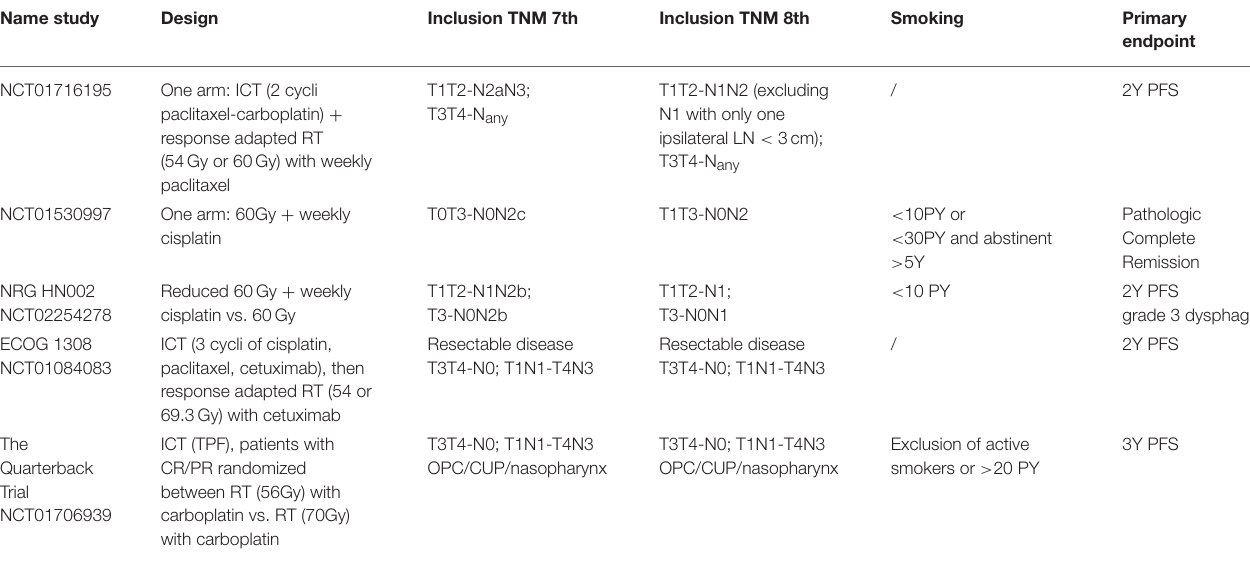
TABLE 3 | De-intensification trials with reduced RT